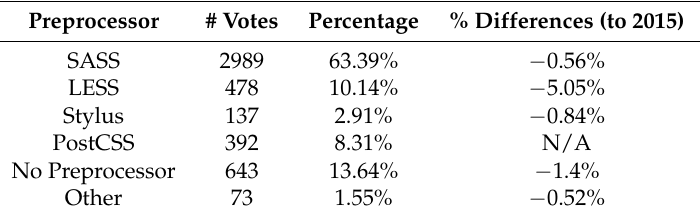
Table 1. CSS Processing